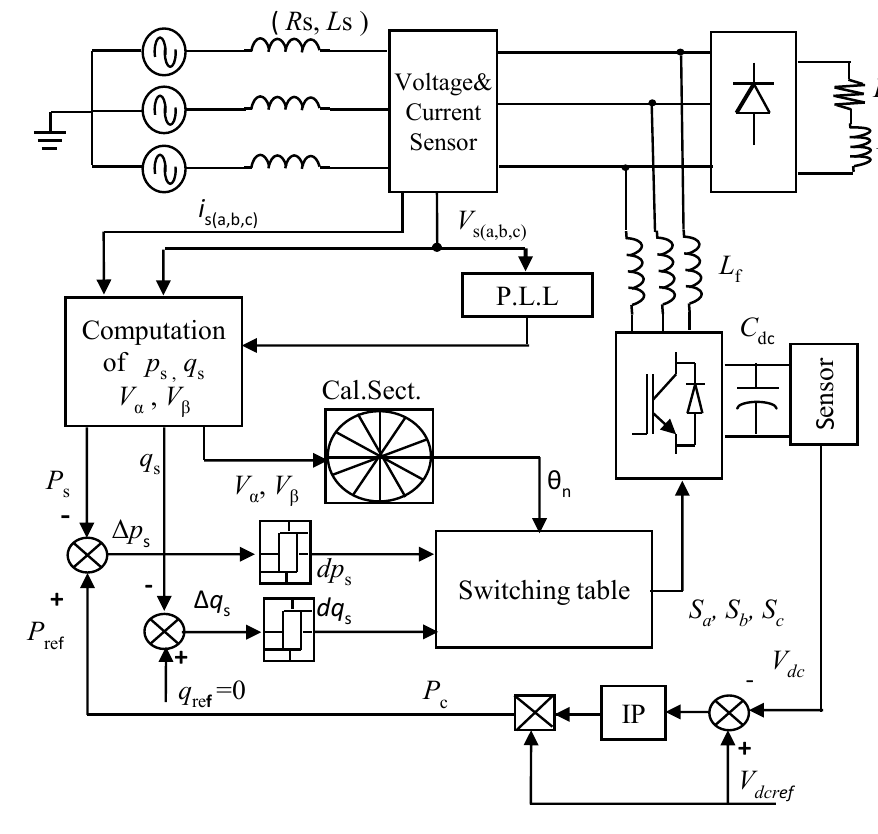
Figure 1. Standard DPC control block